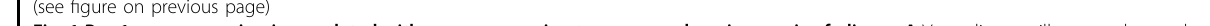
Fig. 1 Prrx1 overexpression is correlated with poor prognosis, stemness, and angiogenesis of glioma. A Venn diagram illustrates the overlap of differential expressed genes (DEGs) between normal and glioma samples in two GEO datasets (GSE4290 and GSE2223). B Volcano plots represent all DEGs of the respective dataset. The red dot represents upregulated genes, the green dot represents downregulated genes, and the gray dot represents unchanged genes. C Transcriptional expression of Prrx1 in 27 different types of cancer from TCGA and GTEx cohorts. D IHC results of Prrx1 protein levels in normal brain tissue and glioma tissue from the Human Protein Atlas (HPA) database (https://www.proteinatlas.org/). E Scatter diagram represents Prrx1 expression level of human brain tissues and glioma tissues from Zhujiang Hospital. The data are normalized to GAPDH. F Left panel represents quanti fi cation analysis of Prrx1 expression in normal brain ( n = 23), grade II glioma ( n = 45), grade III glioma ( n = 31), and grade IV glioma ( n = 81) from GEO: GSE4290. Right panel represents quanti fi cation analysis of Prrx1 expression in normal brain ( n = 23), anaplastic astrocytoma (AA, n = 26), oligodendroglioma (O, n = 50), and glioblastoma (GBM, n = 81) from GEO: GSE4290. G Survival curves for glioma patients with low Prrx1 expression versus high Prrx1 expression through analyzing data from the CGGA database (http://www.cgga.org.cn/). H Gene set enrichment analysis (GSEA) demonstrated stem cell-related pathways in high Prrx1 expression glioma group of multiple glioma datasets. I GSEA demonstrated angiogenesis-related pathways in high Prrx1 expression glioma group of multiple glioma datasets. * P < 0.05, *** P <